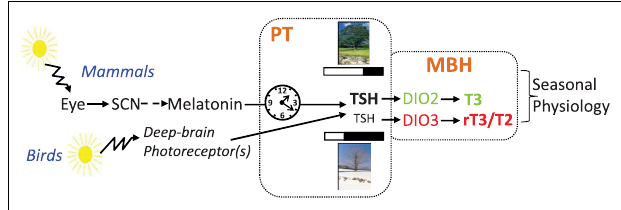
FIGURE 2 | Pathways for photoperiodic entrainment in mammals and birds (see text)